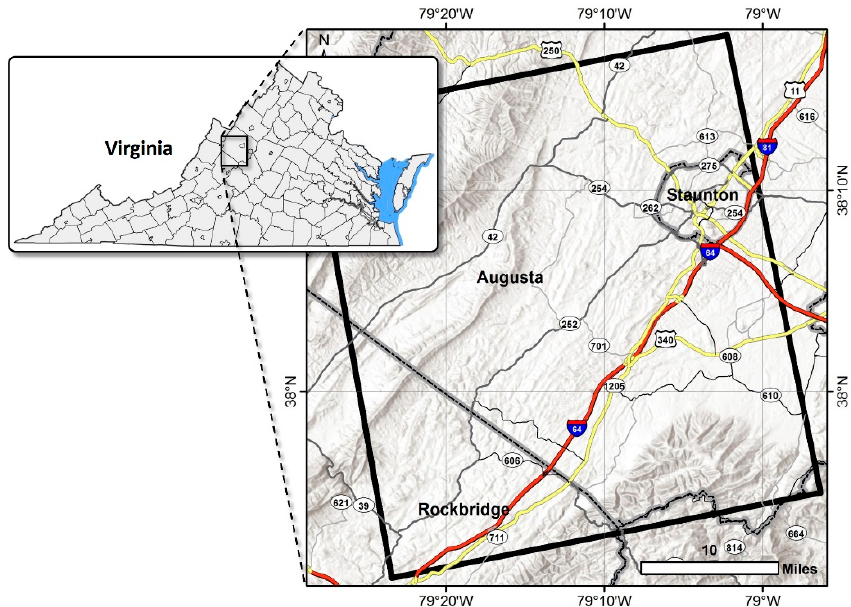
Figure 1. Map of the main area of interest of this study. Our research is focused on a section of the southern half of Augusta County, VA, and encompasses the city of Staunton and its vicinity. The bounding box of the Synthetic Aperture Radar (SAR) frame used in this study is shown by a bold black rectangle.